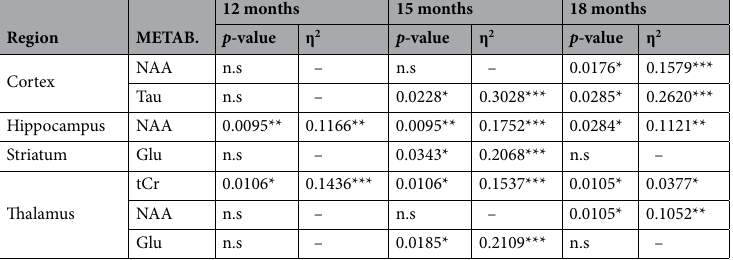
Table 2. Between-group comparison of metabolite concentration at specific time points.